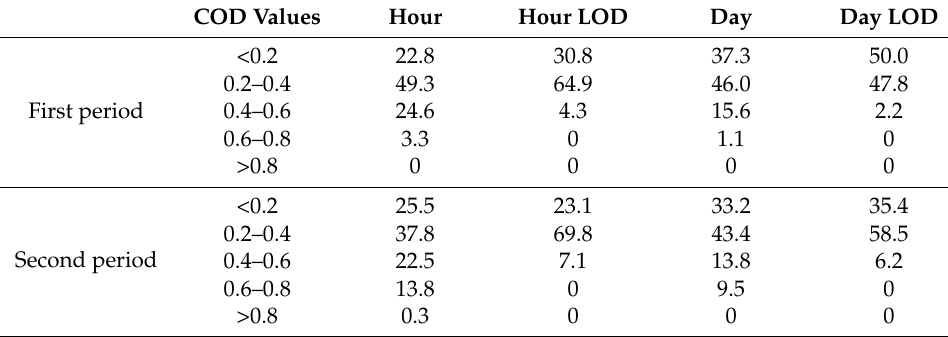
Table 4. Percentage of COD values between each Speck PM concentration pair calculated from hourly and daily averages, from the original and LOD corrected data (denoted as LOD in the